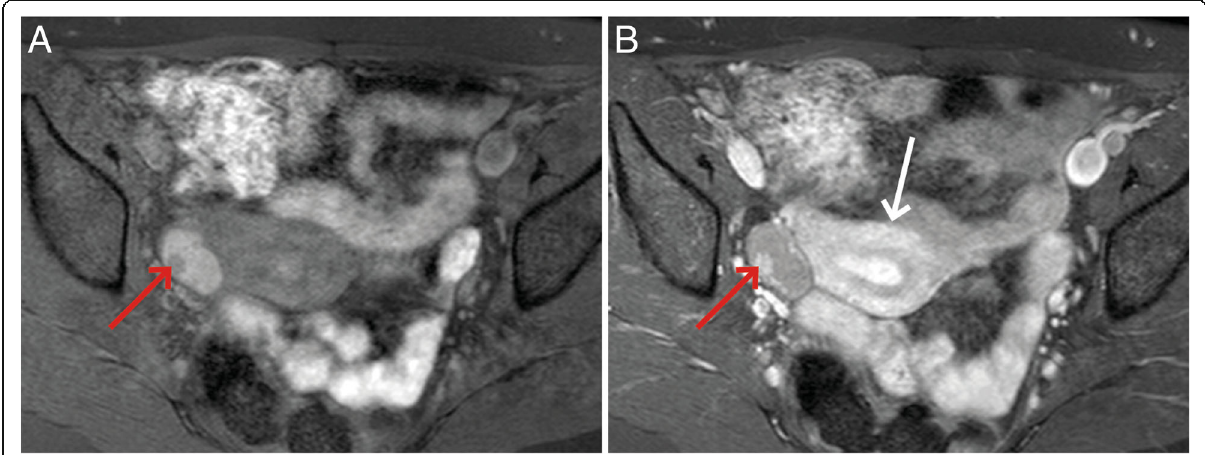
Fig. 1 MRI scan of early-stage 1A high-grade serous ovarian cancer. The BRCA1-positive patient was identified through ultrasound screening, confirmed by MRI. The right ovary contains as cyst with an enhancing nodule (red arrows) demonstrated on the T1 fat-saturated image before ( a ) and after ( b ) contrast administration. The nodule enhances brightly, similar to the adjacent uterine myometrium (white arrow). Detection of ovarian cancer at this early stage is associated with a significantly improved 5-year survival rate compared with later stages of disease (courtesy: A. Rockall)